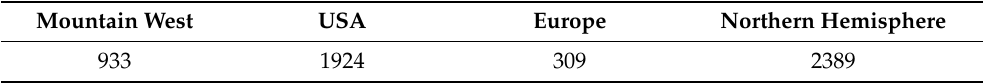
Table 1. Total number of samples in each dataset. Mountain